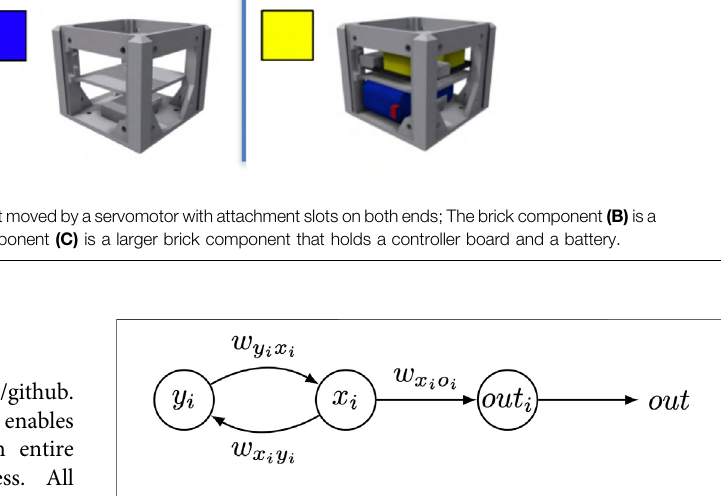
FIGURE 2 | A single CPG. i denotes the speci fi c joint that is associated with this CPG. w x , w y , and w x denote the weights of the connections i y i i x i i o i between the neurons, and out is the activation value of out i -neuron that controls the servo in a